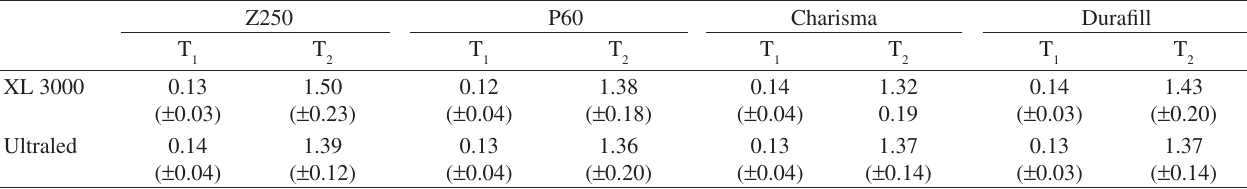
Table 3. Mean values and standard deviations of the